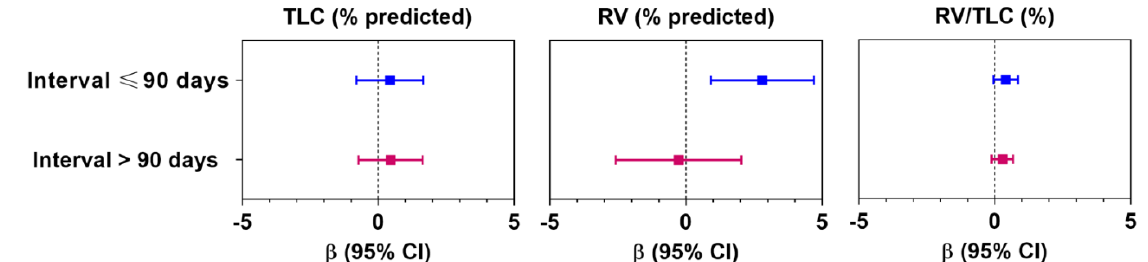
Figure 3. Association between changes in lung function in association with per interquartile (IQR) change in air pollution index stratifying by interval (days between deployment and screening). Data presented as linear regression coefficient (β) and 95% confidence interval, unless otherwise specified. Coefficients were calculated with respect to per IQR change ( µ g/m 3 ) of the air pollution index (principal component). In adjusted models, age, sex, BMI, race, and smoking history were considered as confounders. For abbreviations, see text.